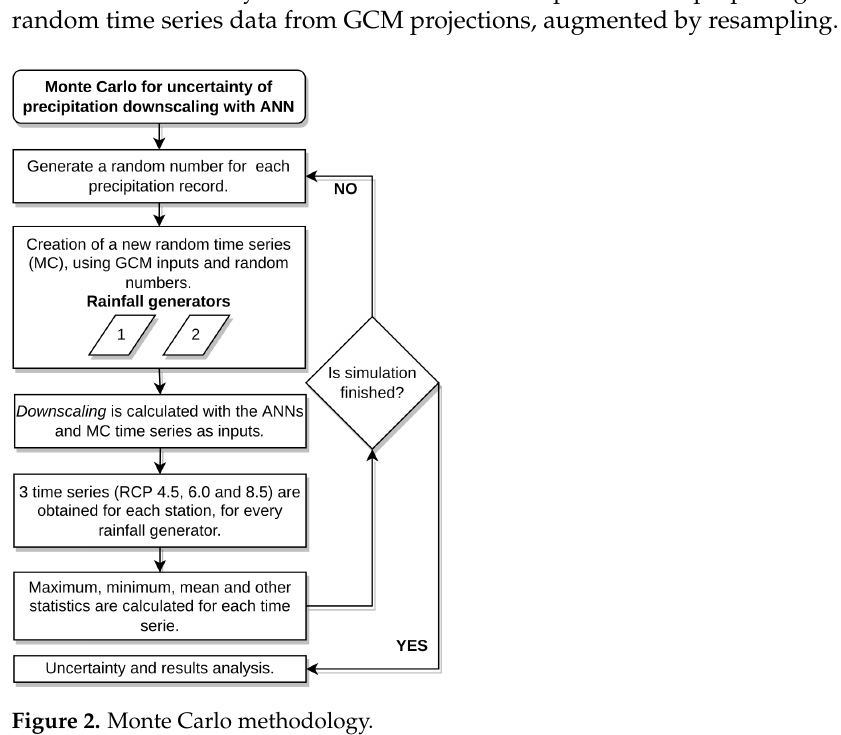
Figure 2. Monte Carlo